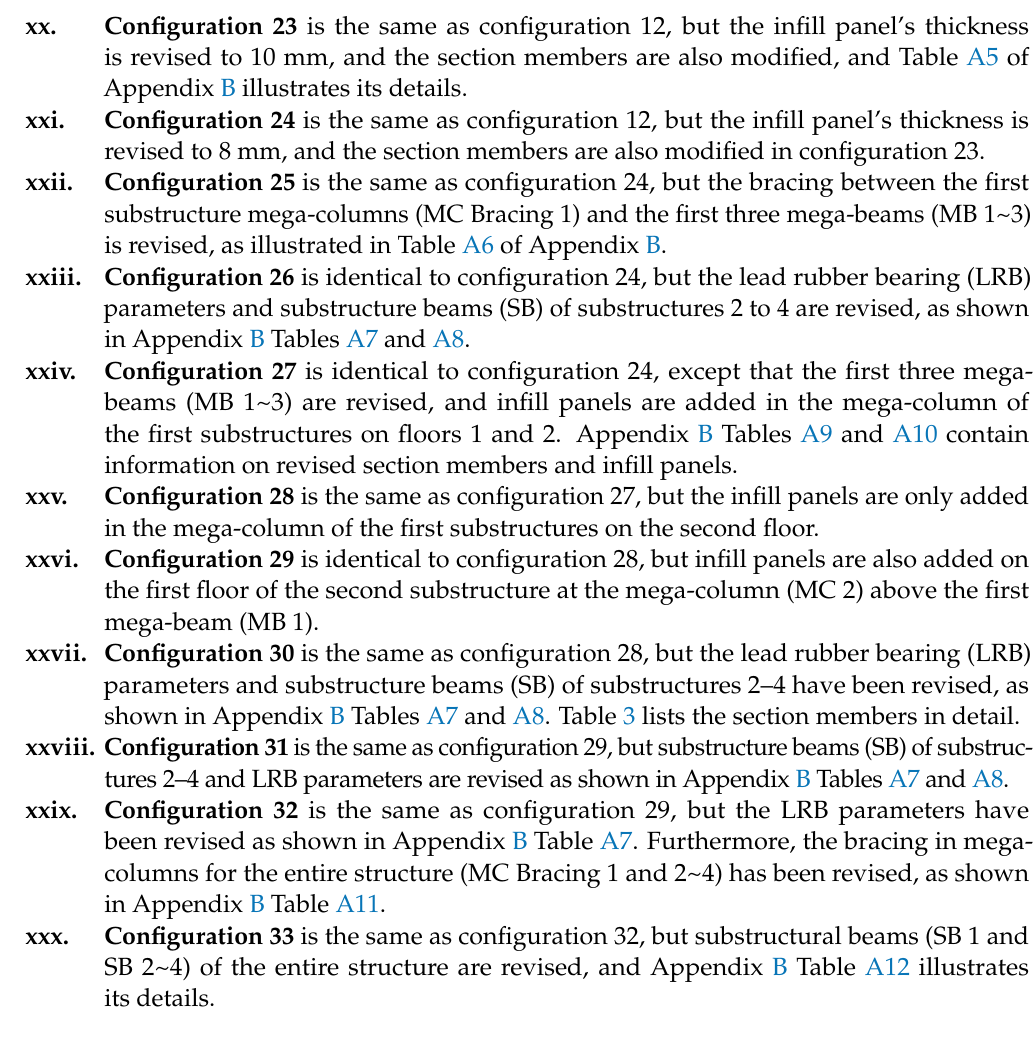
Table 2. Ring-Shaped Infill Panel Dimensions (5 m × 4